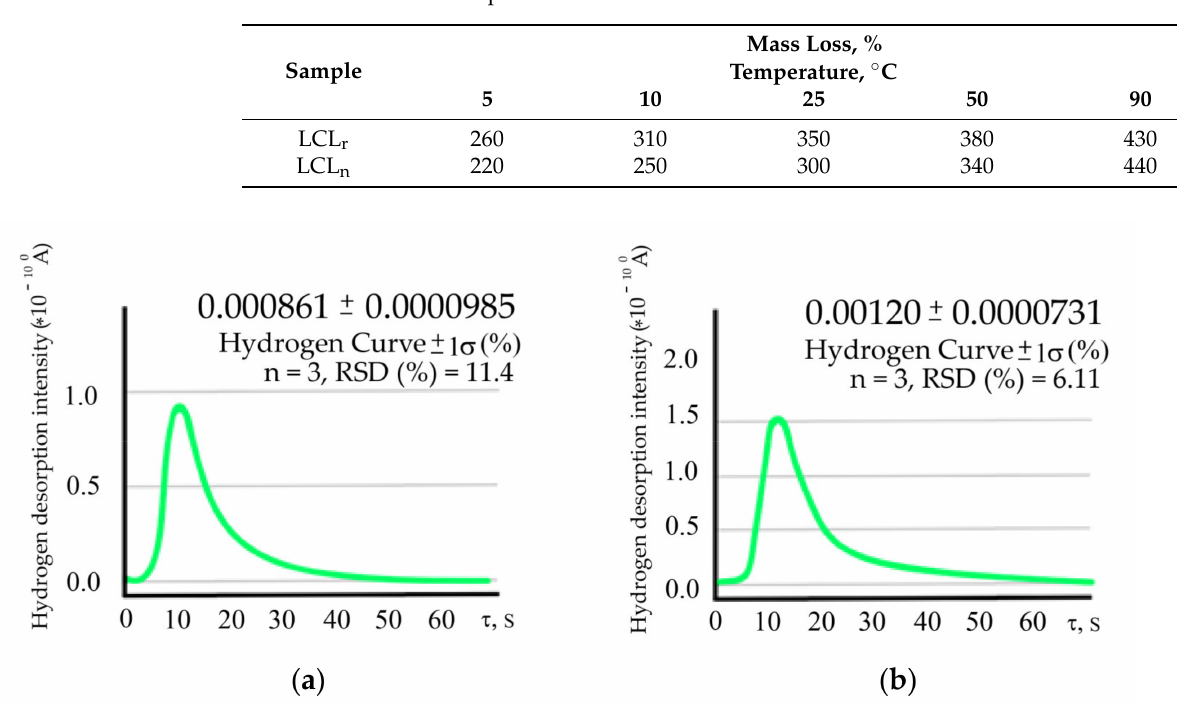
Table 5. Influence of temperature on LCL mass loss.